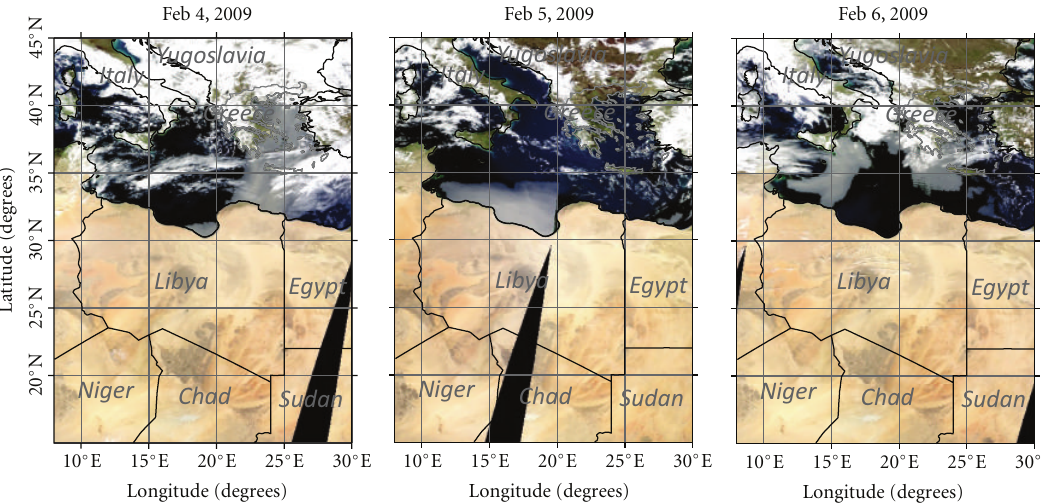
Figure 1: Terra-MODIS true color RGB images along the satellite swath over eastern Mediterranean for 4–6 February 2009. Two images are provided for 5 February in order to cover both Libyan desert and eastern